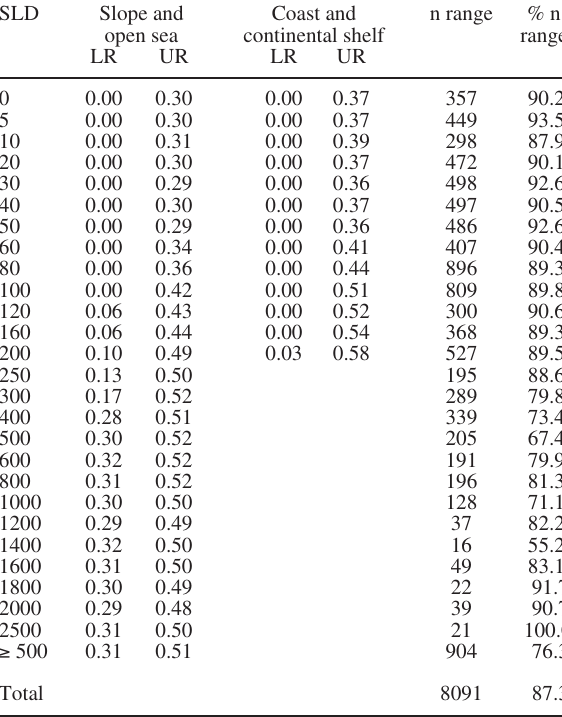
Table 8. – Nitrate concentration ( m M) ranges in the NW Mediter- Table 7. – Phosphate concentration ( m M) ranges in the NW Medi- ranean Sea in stratified water columns (stratification coefficient = 2, terranean Sea. SLD, Standard Level Depth; LR, Lower Range; UR, 3 and 4). Headers as in Table Upper Range; Coast and continental shelf stations have a bottom depth less than 200 m. Slope and open sea stations have a bottom depth larger than 200 m. n, amount of data within the range; % n range, proportion of the total amount of data included in the range at each SLD.